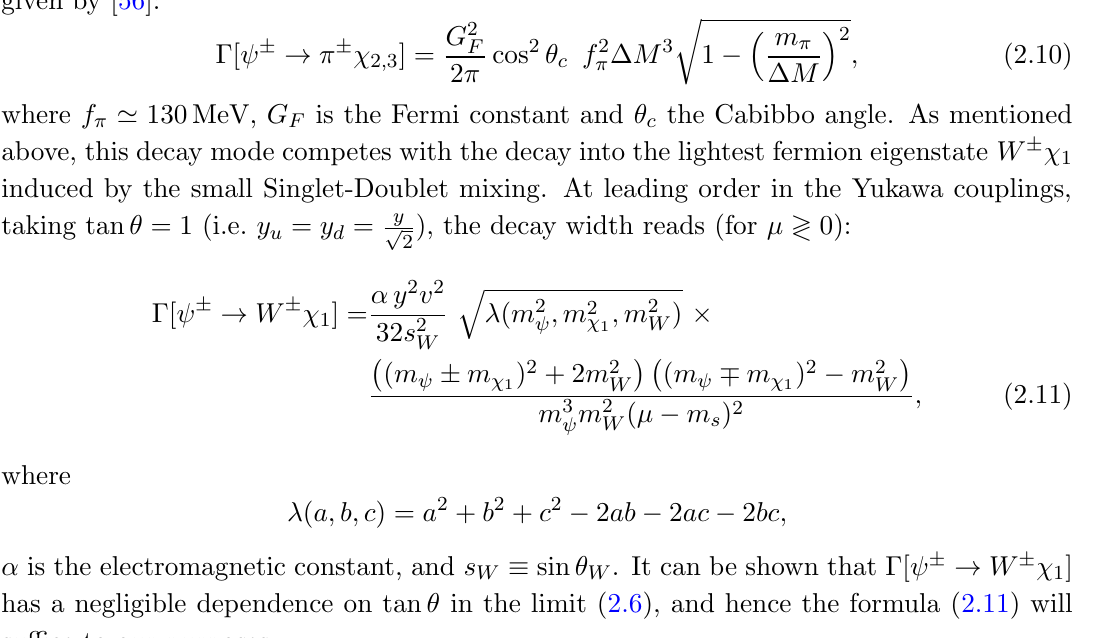
plus a pion. Right: 2 ; 3 = 10 1